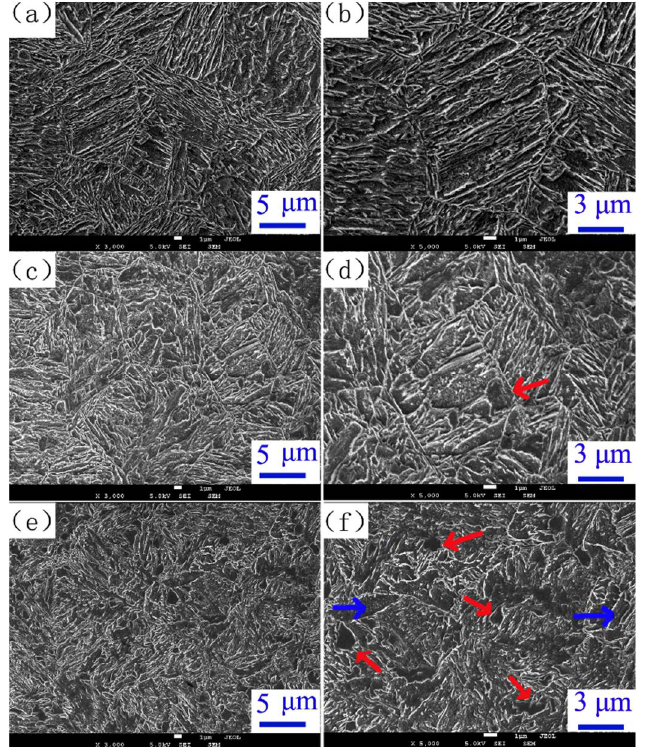
Figure 3. Secondary electron micrographs of the samples quenched to 220 °C partitioned at 400 °C for ( a , b ) 12 s, ( c , d ) 90 s, and ( e , f ) 600 s.